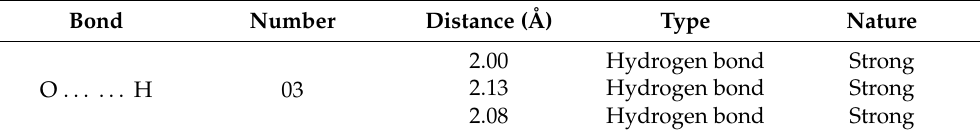
Table 2. Interactions in the system—cellulose hydrogel/HEMA monomer (ECH = 1%). Bond